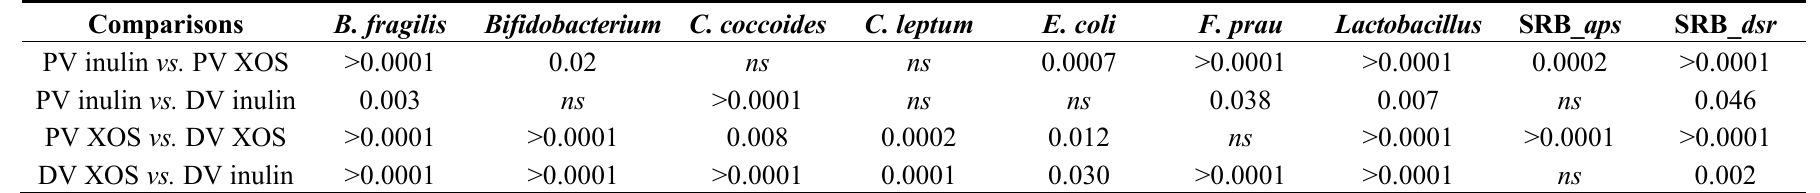
Table 4. Statistical differences ( p < 0.05) between substrates within individual vessels and for substrates between vessels for each bacterial group/species. PV: proximal vessel; DV: distal vessel. SRB: Sulfate-reducing bacteria, aps : Adenosine-5-phosphosulfate reductase gene, dsr : Dissimilatory sulfite reductase